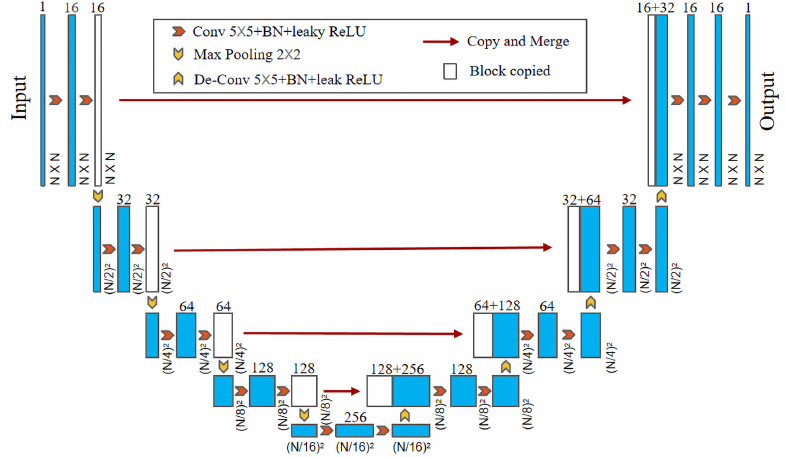
Figure 3. Diagram of neural network